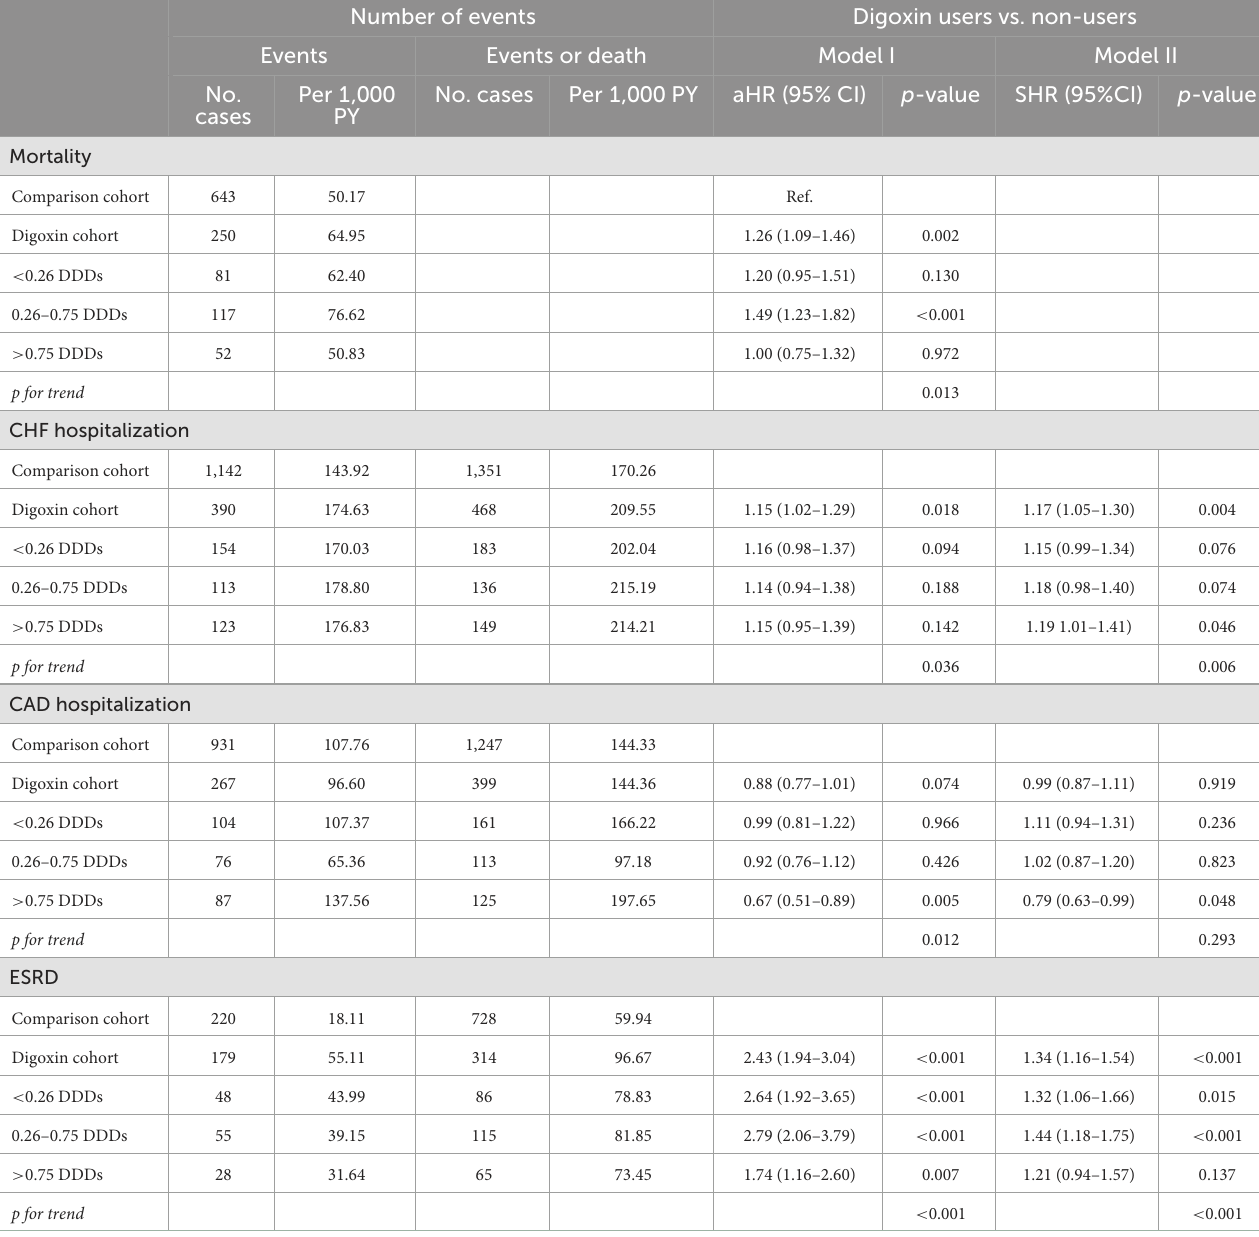
TABLE 2 Risk of mortality, CHF recurrence, CAD recurrence, and ESRD between digoxin users and non-users ( N = 2,820). Number of events Digoxin users vs. non-users